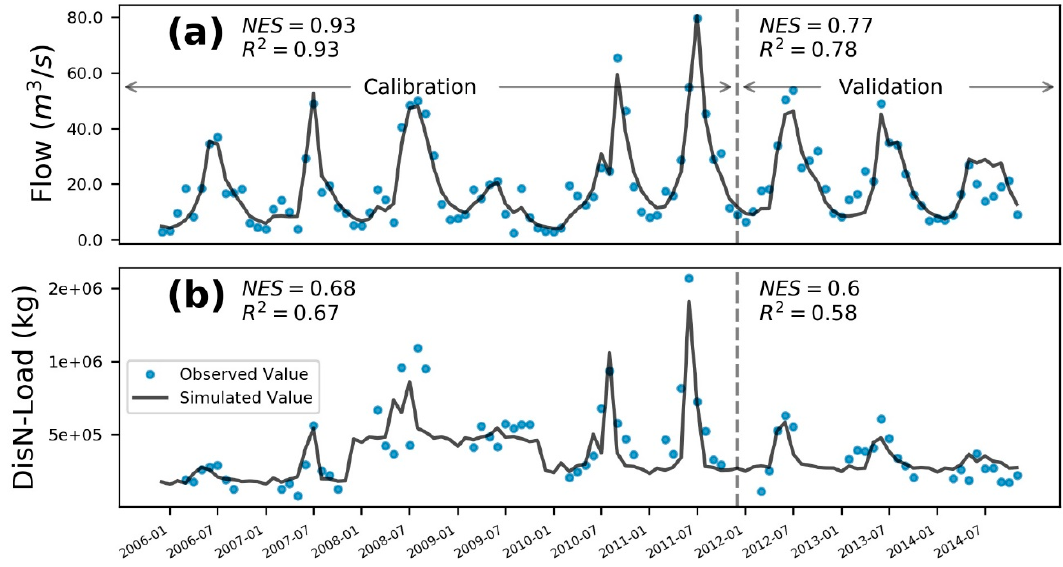
Figure 4. Time-series for the entire period (2006–2014) of observed and simulated monthly streamflow ( a ) and dissolved nitrogen ( b ).